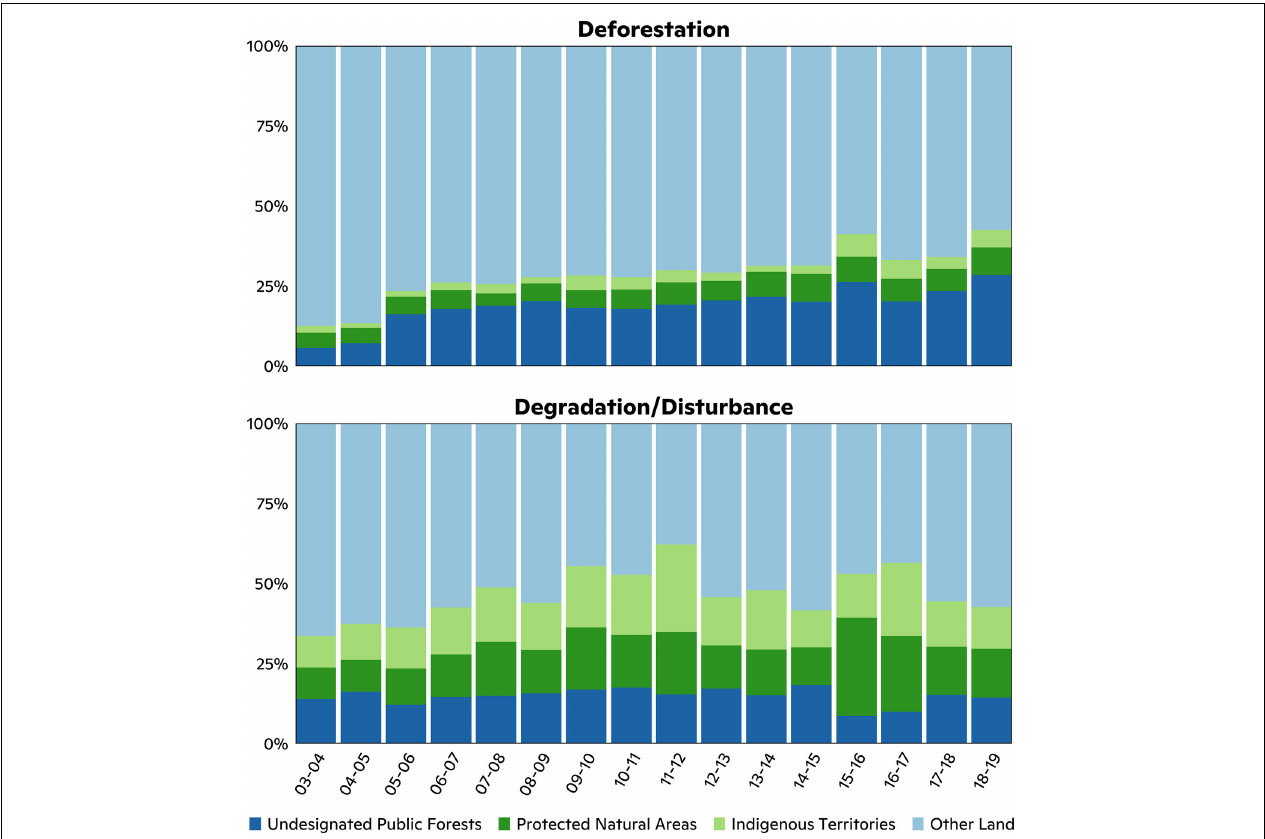
FIGURE 5 | Proportion of annual gross carbon losses due to forest conversion (deforestation; top) and degradation/disturbance (bottom) associated with each land tenure category from 2003 to